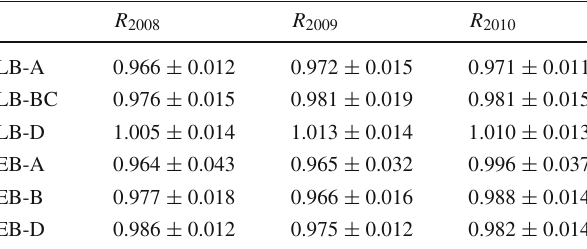
Table 5 Double ratio given in Eq. (4) by the ratio of the experimental and simulated (cid:4) E /(cid:4) x truncated means for different layers in the long barrel (LB) and extended barrel (EB), for the three data periods using cosmic-muon data. The sources of uncertainty are described in the text. Larger uncertainties in the EB-A layer reflect that fewer cosmic muons satisfy the selection criteria. A maximum difference of 4% is observed between the layer